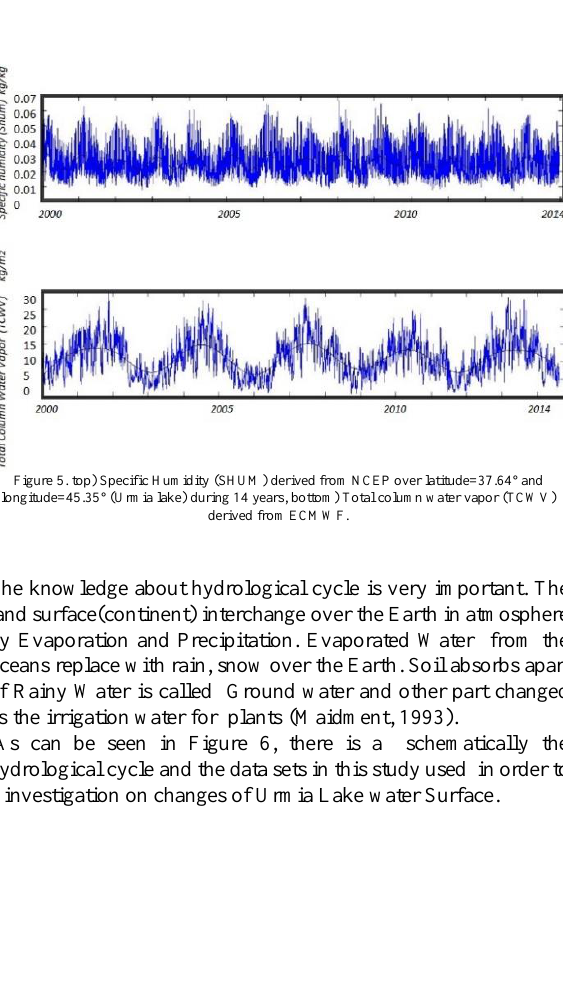
Figure 4. Urmia lake water level time series obtained from ENVISAT, ENVISAT extended mission and CryoSat-2 during 2000 to 2014 years.